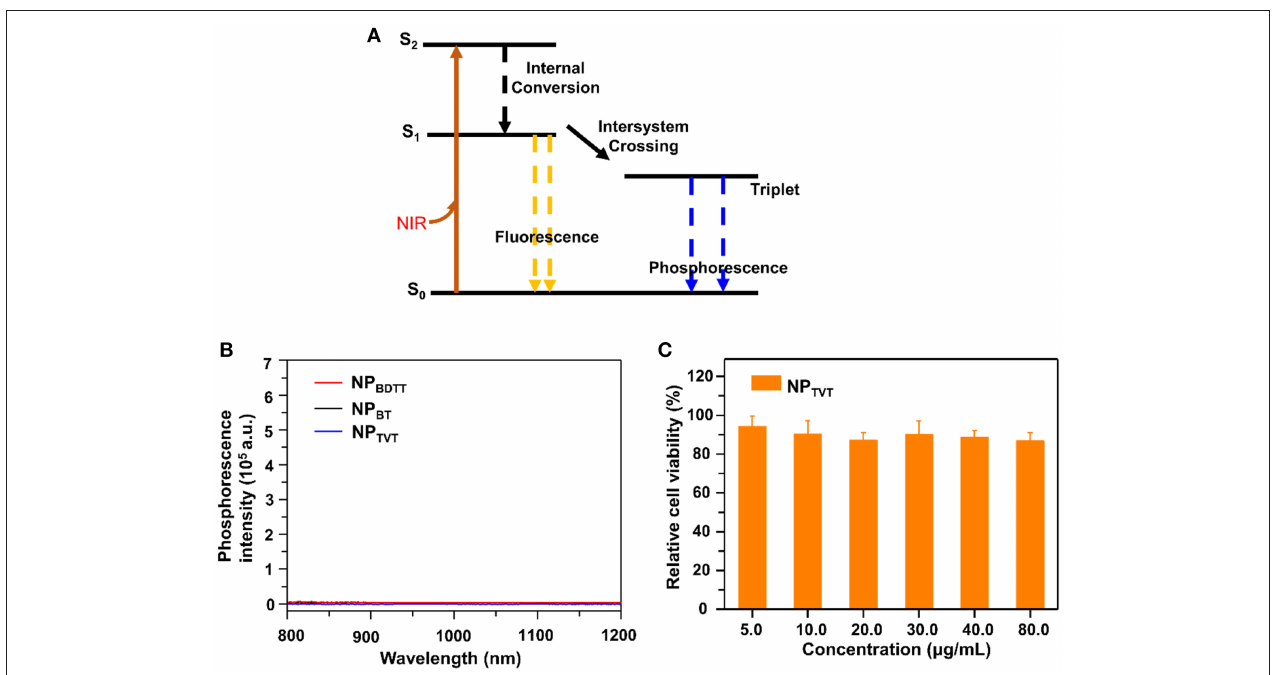
FIGURE 5 | (A) Energy level diagram. (B) Phosphorescence spectra of NP BDTT , NP BT , NP TVT upon excitation at 808nm. (C) Cell viability of 231 cells in the presence of NPs treated with different concentrations.